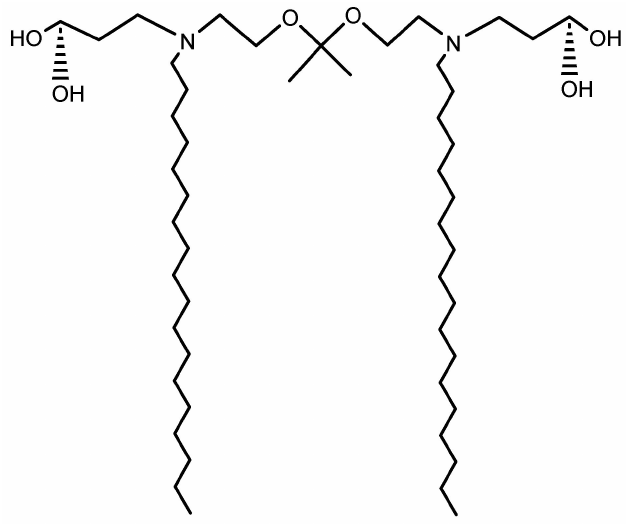
Figure 9. Acetal-based BD2 lipid